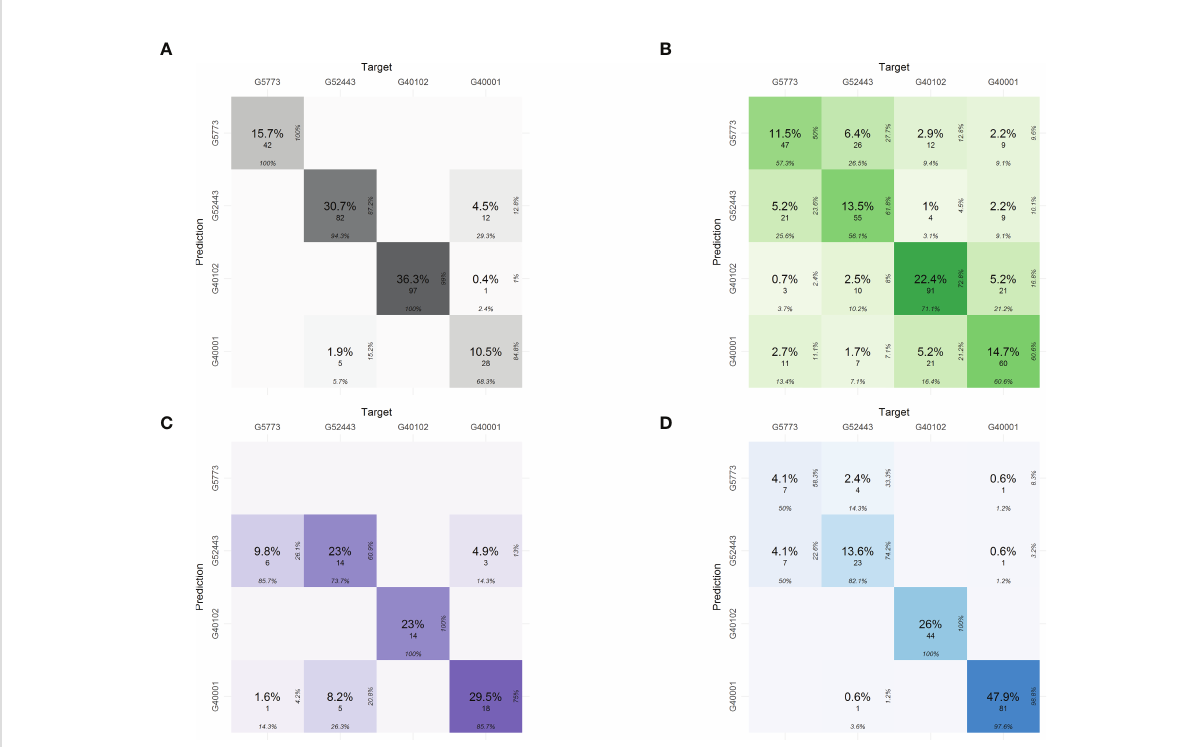
FIGURE 5 Phenomic proportions in the confusion matrices for classi fi cation of the interspeci fi c hybrid in each of the characterization components using phenomics descriptors. (A) Seed morphometric component, (B) Physiological component, (C) Pod morphometric component and (D) Yield component. The confusion table shows the phenomic proportions of the interspeci fi c hybrid. The phenomic proportions are the predictions of the hybrid with respect to the parental